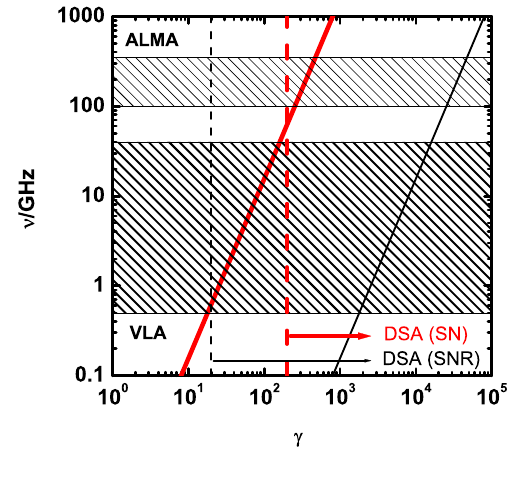
Figure 3: The relation between the electron’s energy and the synchrotron frequency, for B ∼ 1G typical of young SNe (red-thick-solid) and ∼ 100 µ G typical of SNRs (black-thin-solid). Also shown is the minimum electron energy for the efficient DSA, adopting V ∼ 0 . 1 c (SNe; red-thick-dashed) and 0 . 01 c (SNRs; black-thin- dashed). The typical frequency coverage is shown by the shaded areas, for cm (‘VLA’) and mm (‘ALMA’) observations